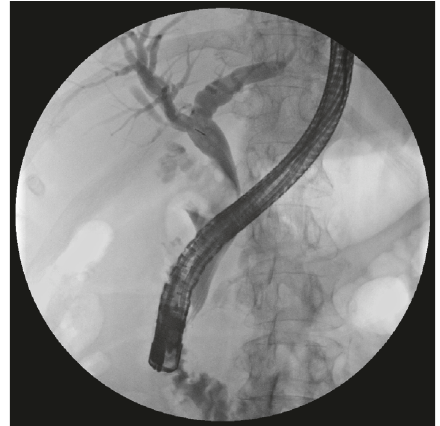
Figure 2: ERCP in a case of Mirizzi type I: note the smooth and regular stricture.